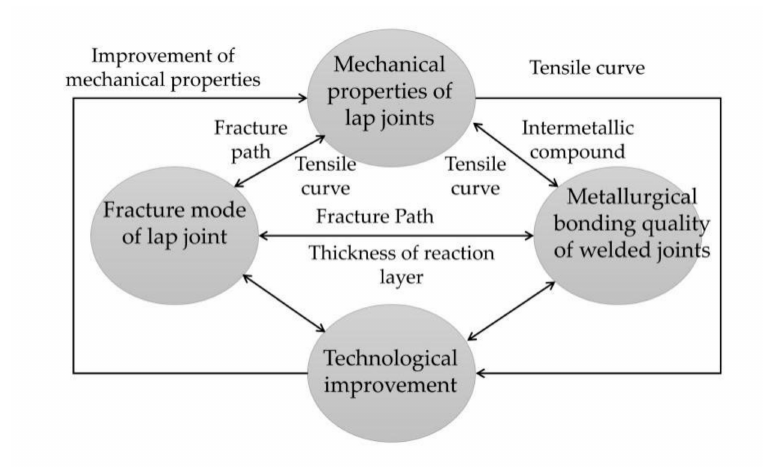
Figure 11. Schematic diagram of the relationship among the properties of thee lap joint, metallurgical combined quality, fracture modes, and brazing